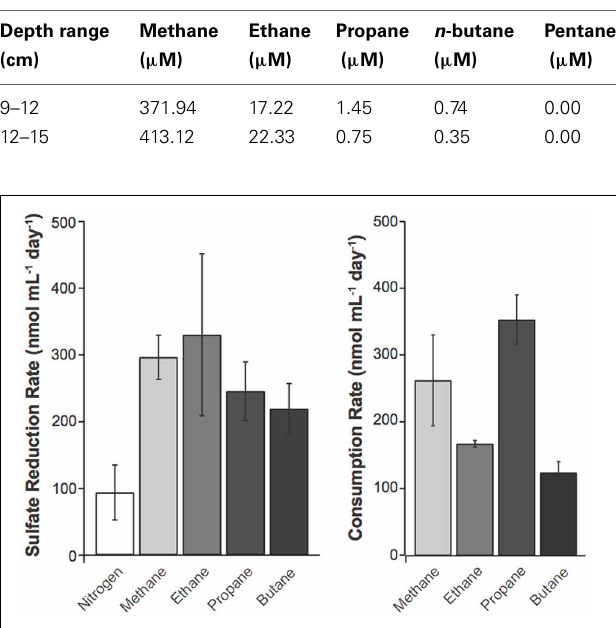
FIGURE 2 | Potential sulfate reduction rates (SRR) were measured using the 35 SO 2 − 4 radiotracer method (Fossing and Jorgensen, 1989) and consumption rates for C 1 –C 4 alkanes by alkane amended slurries of GoM site GB425 sediments. The SRR assays were performed for 24h. Values represent average ± standard deviation of triplicate measurements of duplicate incubations. Alkane consumption rates were calculated from a linear regression as in Figure 1 . Rates of sulfate reduction were calculated as described in the methods.